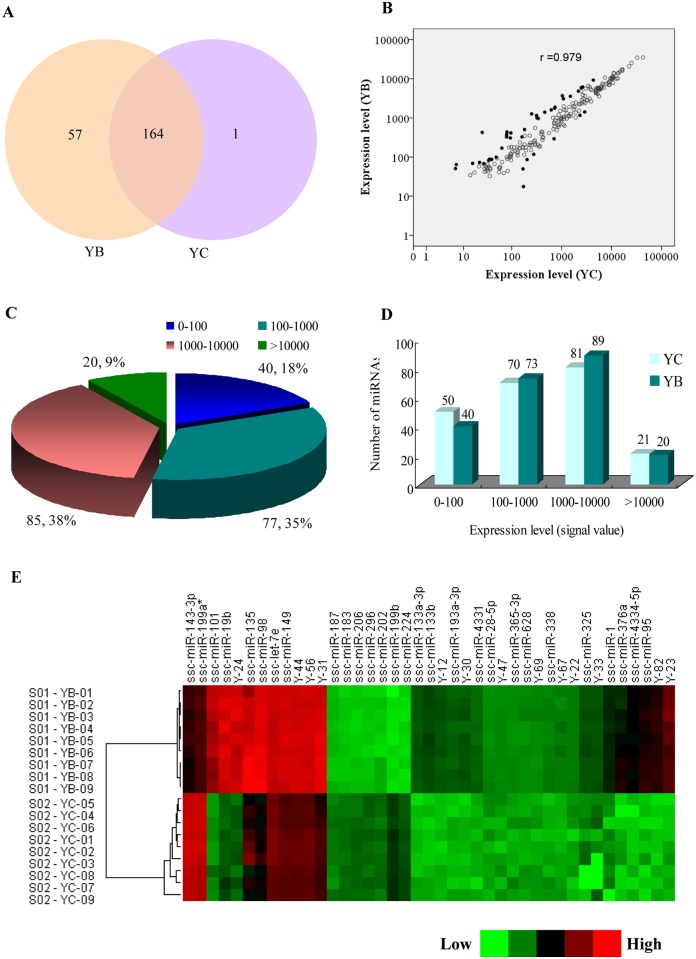
miRNA expression and distribution.(A) miRNA numbers of two pig breeds; YB and YC indicate Bama minipigs and Landrace pigs, respectively. (B) Scatter plots of miRNA expression; r represents correlation between Bama minipigs and Landrace pigs and the solid dots represent significantly changed miRNAs. (C) The average expression levels of miRNAs and their corresponding proportion in the anterior pituitary. (D) The miRNA numbers of the two pig breeds at different expression levels. (E) Cluster analysis of differentially expressed miRNAs between YB and YC. YB and YC indicate Bama minipigs and Landrace pigs, respectively.